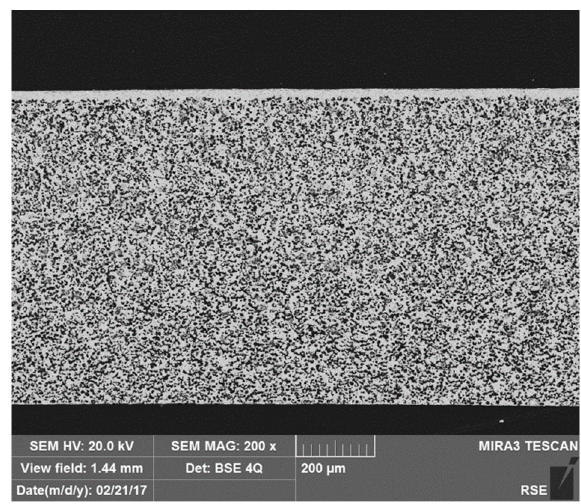
Figure 3. Image of the polished cross section of an asymmetric membrane.